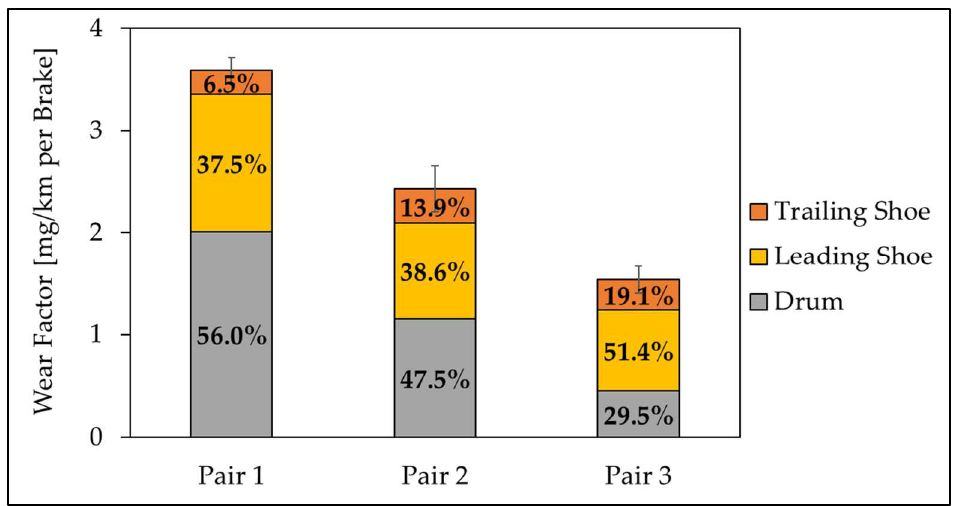
Figure 12. Wear factors of the three different drum brake shoe compositions after 8× WLTP Brake Cycle.